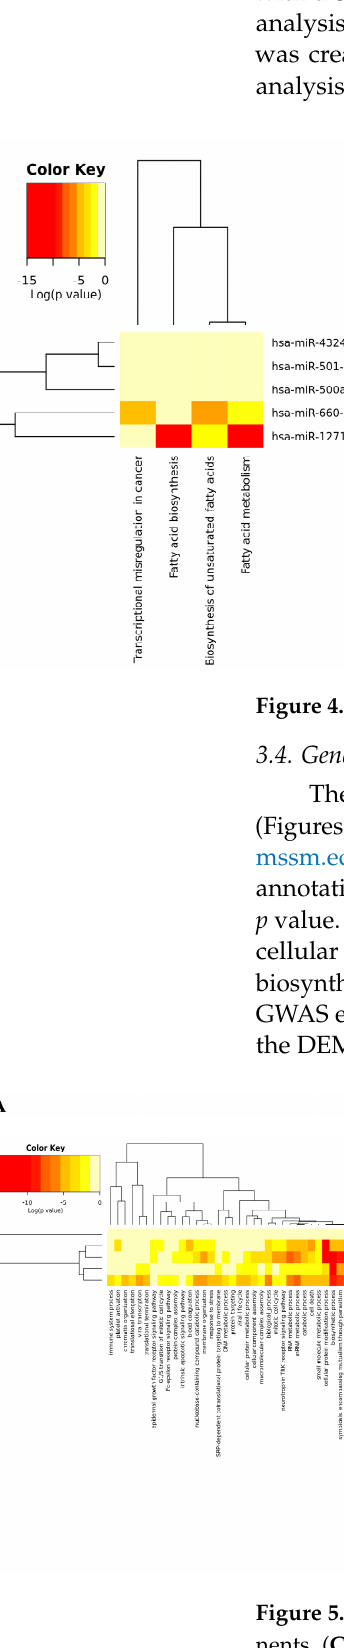
. Figure 6. Gene ontology of upregulated miRNAs. (A) Biological processes. ( B) Cellular components. (C) Molecular functions.